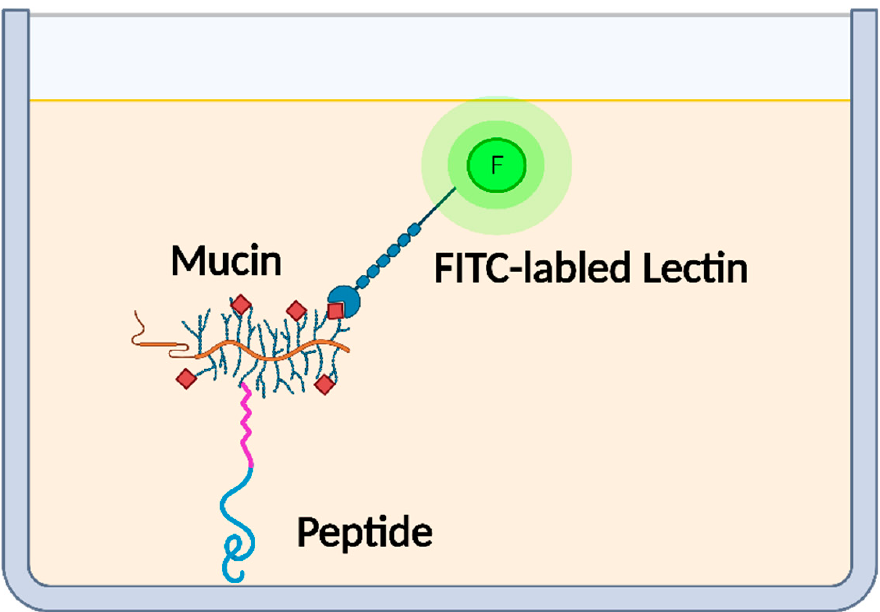
Figure 2. Schematic diagram of peptide-mucin binding assay (Image created with BioRender).